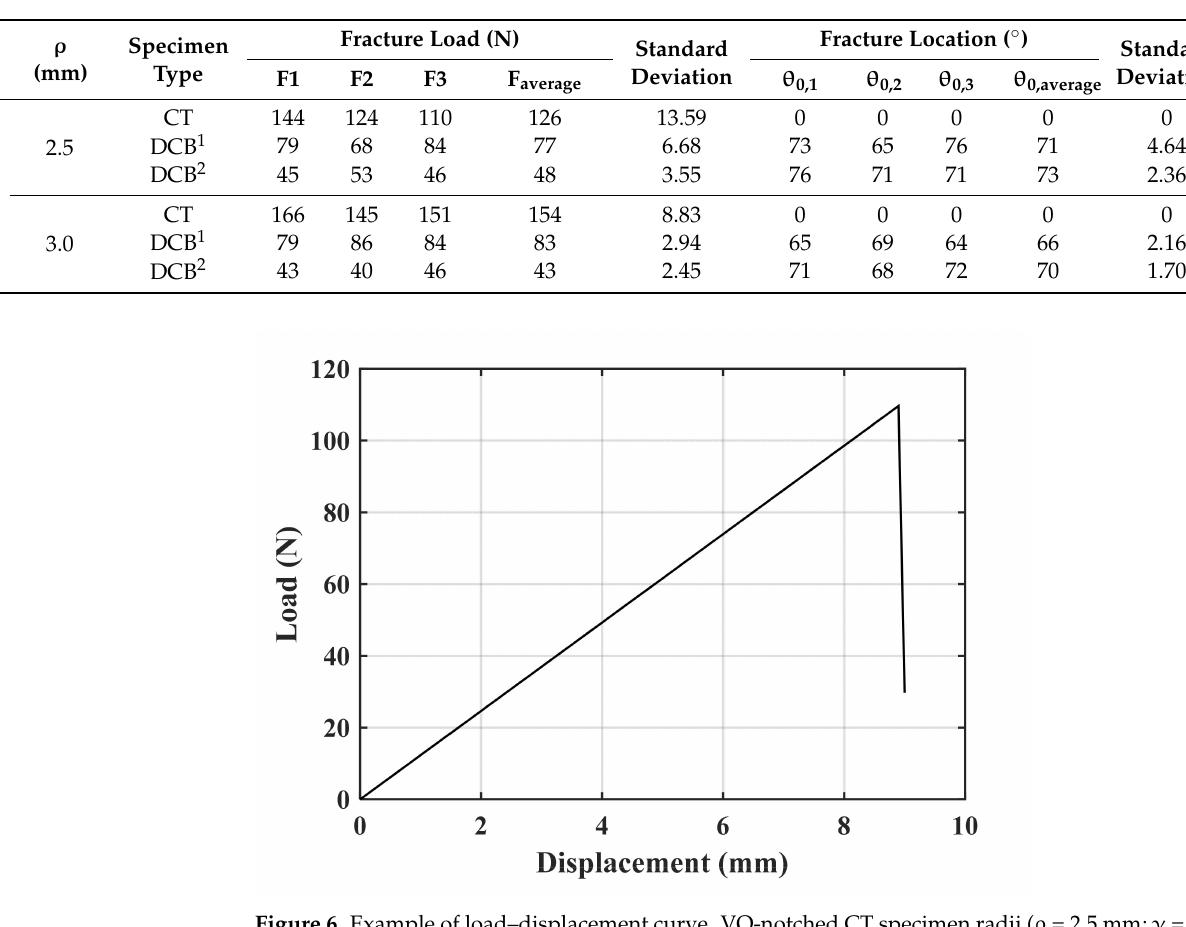
Figure 6. Example of load–displacement curve. VO-notched CT specimen radii ( ρ = 2.5 mm; γ = 30 ◦ ).